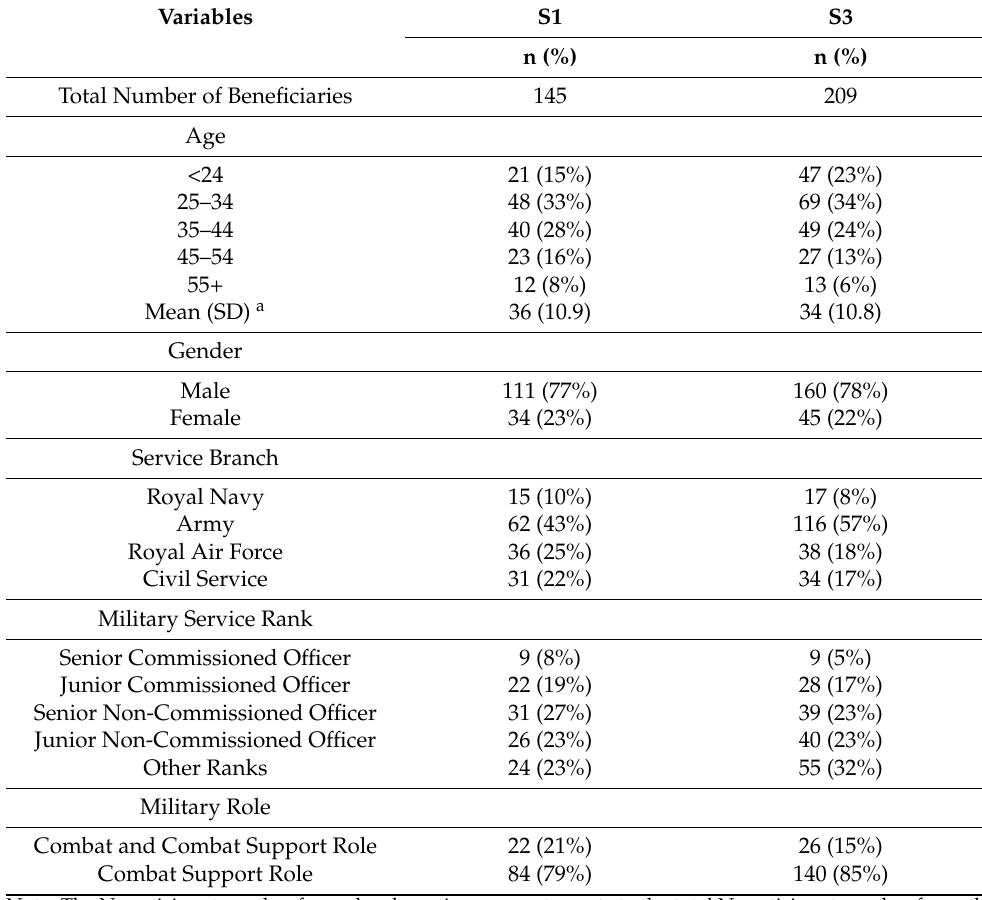
Table 1. Description of Beneficiaries’ Demographics and Occupational